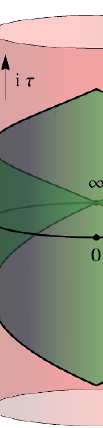
Figure 6 . The Poincar(cid:19)e patch in the cylinder coordinates, with i(cid:28) = i log j x j running vertically and ~x= j x j represented by an angle in the horizontal plane. The points labeled 0 and 1 correspond to the origin and spatial in(cid:12)nity of Minkowski space, and both of them lie on the quantization surface (cid:28) =